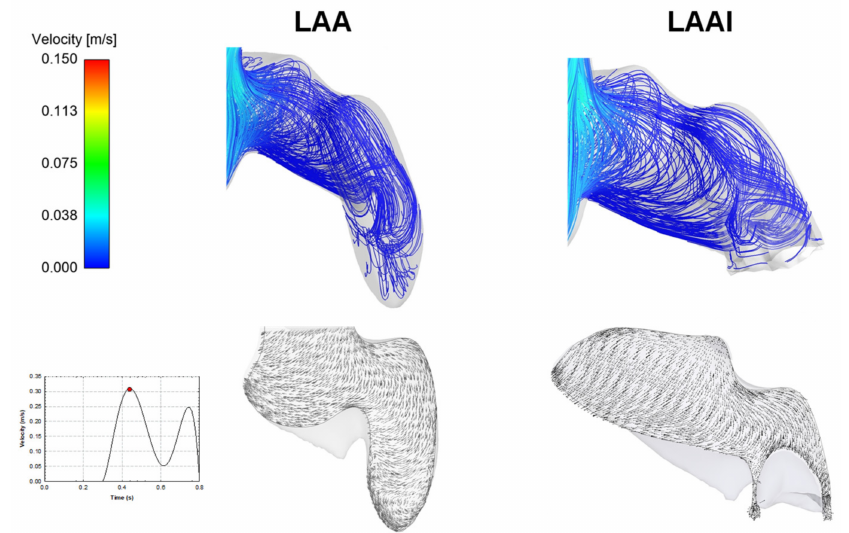
Figure 6. Flow velocity streamlines (top row) and velocity vector at a cross section for both the LAA and